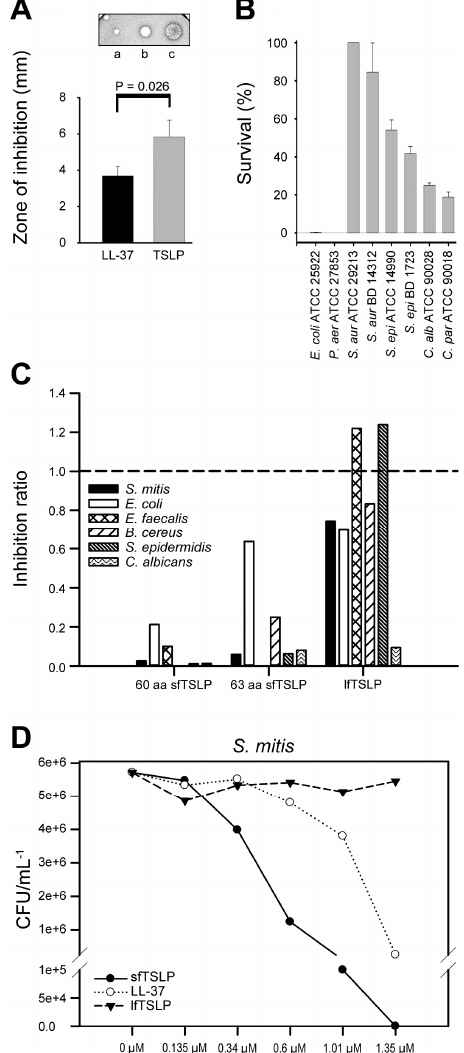
Figure 5. Antimicrobial activity of short and long forms of thymic stromal lymphopoietin (sfTSLP and lfTSLP). ( A ) lfTSLP exhibited a larger zone of inhibition of growth of Escherichia coli ATCC 25922 in comparison with LL-37: (a) control; (b) 10 μ M LL-37; and (c) 10 μ M TSLP. Mean values and standard deviations (n = 4). ( B ) In a viable count assay, indicated bacterial ( Escherichia coli, Pseudomonas aeruginosa, Staphylococcus aureus , and Staphylococcus epidermidis ) and fungal isolates ( Candida albicans and Candida parapsilosis ) were subjected to 2 μ M of TSLP. The number of cfu was registered. ( C ) Suspensions of the indicated bacterial and fungal species were treated for 2 h with 60 amino acid (aa) sfTSLP, and 63 aa sfTSLP or lfTSLP peptide at a concentration of 1.35 mM before being plated on agar. Colony-forming units per ml were determined after incubation overnight. The values were normalized to the levels obtained without the addition of test peptides (broken line). ( D ) Suspensions of Streptococcus mitis were treated with equimolar concentrations of 60 aa sfTSLP, LL-37, or lfTSLP and analyzed as in C. From: [7] ( A , B ) and [5] ( C , D ).